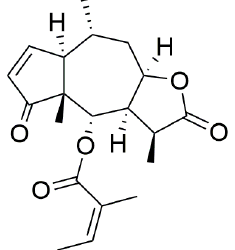
Figure 1. The chemical structure of brevilin A.